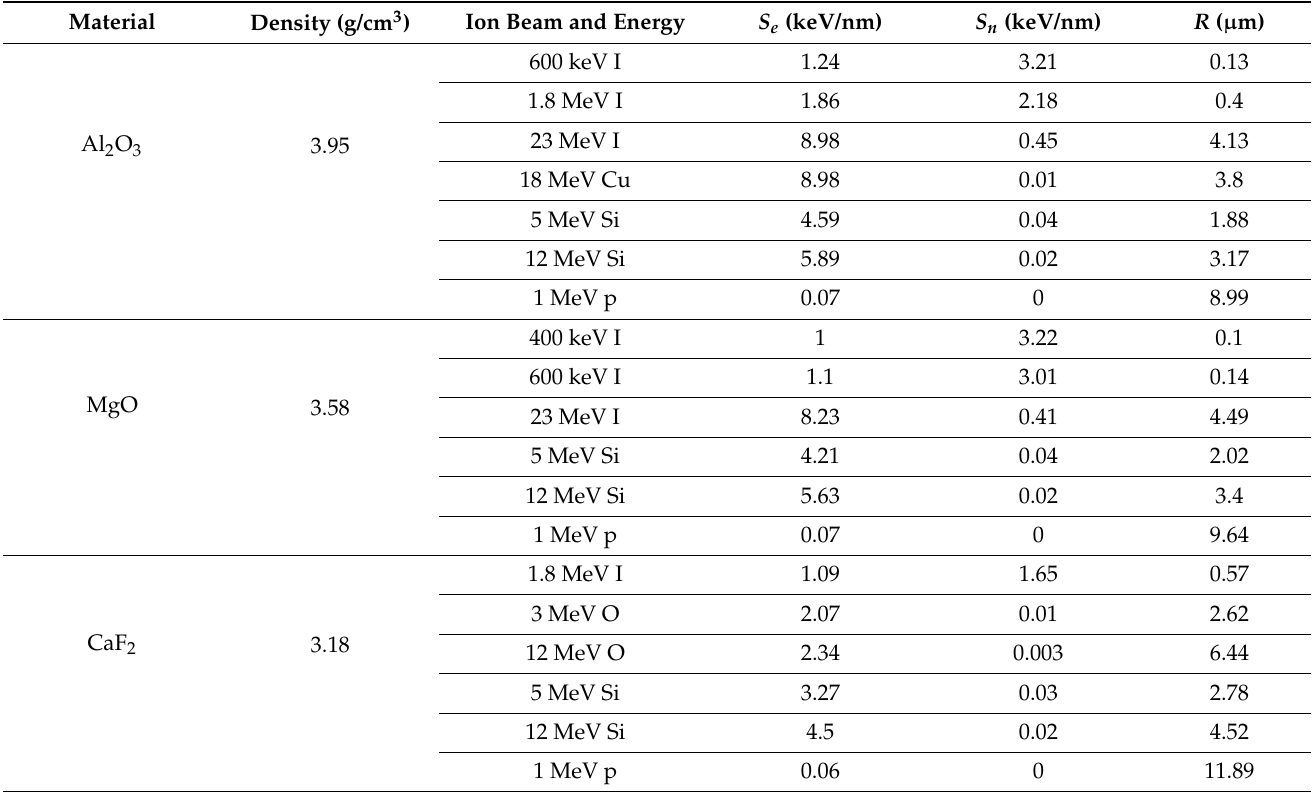
Table 1. List of ion beams used in the present study. Electronic stopping S e , nuclear stopping S n and ion ranges R were calculated using the SRIM code